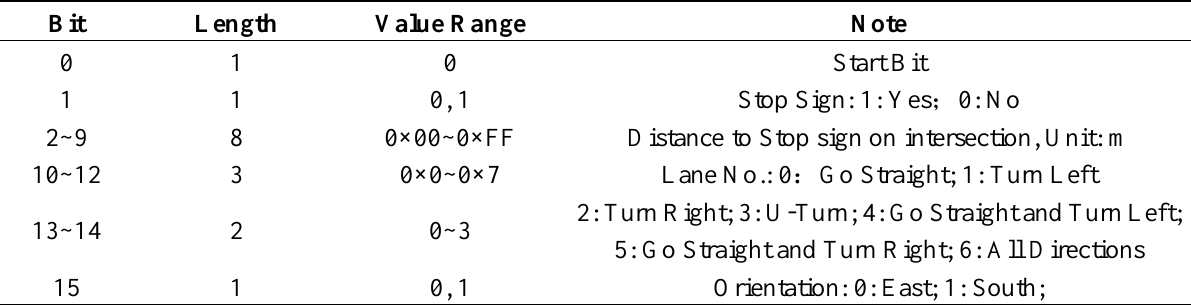
Table 1. Definition of the data stored in RFID